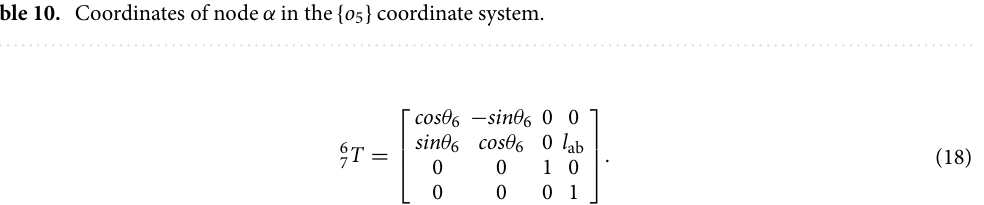
Key nodes of the advanced hydraulic